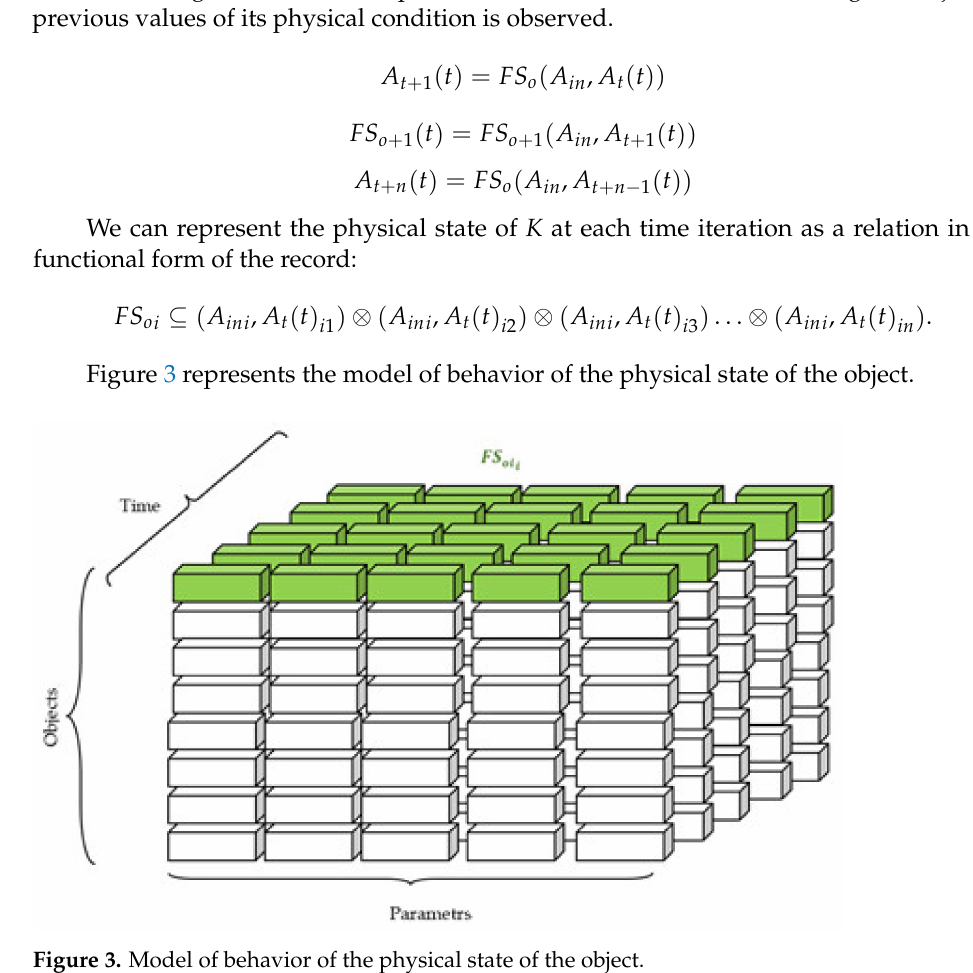
Figure 3. Model of behavior of the physical state of the object. FS oi is only an indicator of the physical condition of SO during the process of treatment or rehabilitation. Due to this, the presented relationship can be analyzed to understand the behavior of the object under